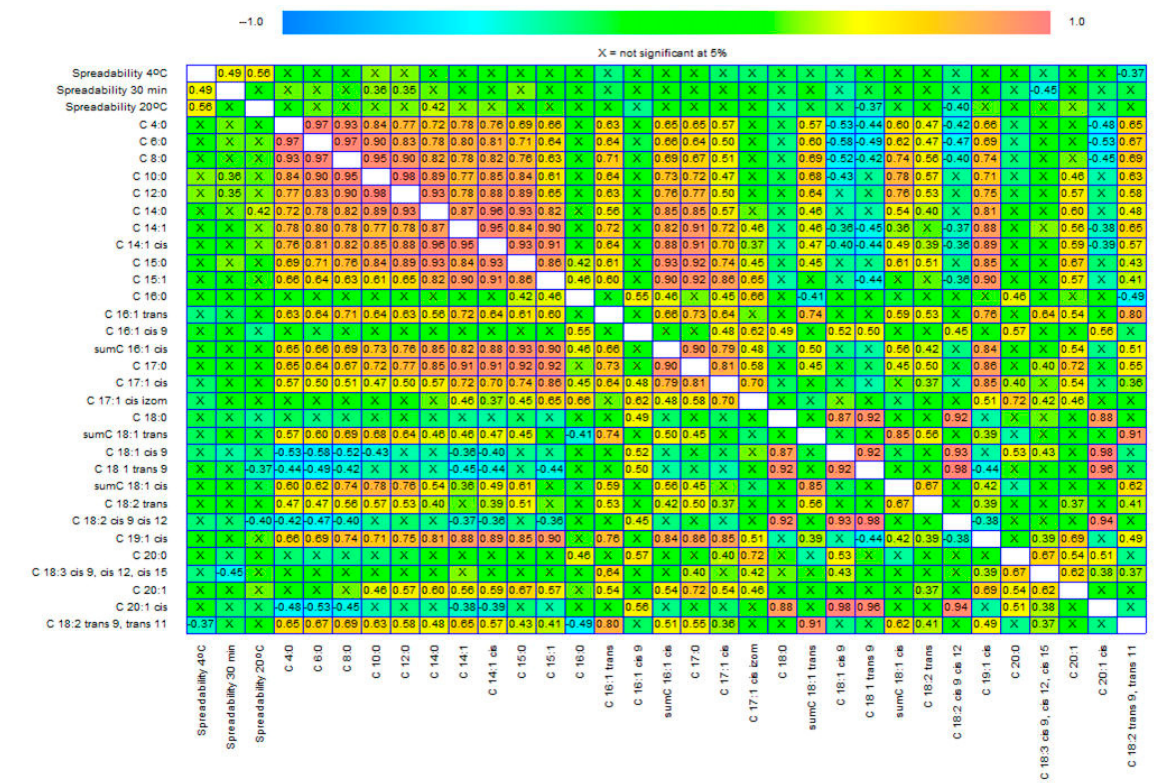
Figure 3. Graphs of correlation matrix showing the relationship between spreadability, acid value, saponification number and SFA, MUFA, and PUFA fatty acid profile ( a ), as well as between spreadability, and the fatty acid percentage share (the percentage for each fatty acid determined) of butter samples ( b ) measured at different temperatures (with a confidence level of 95.0%).